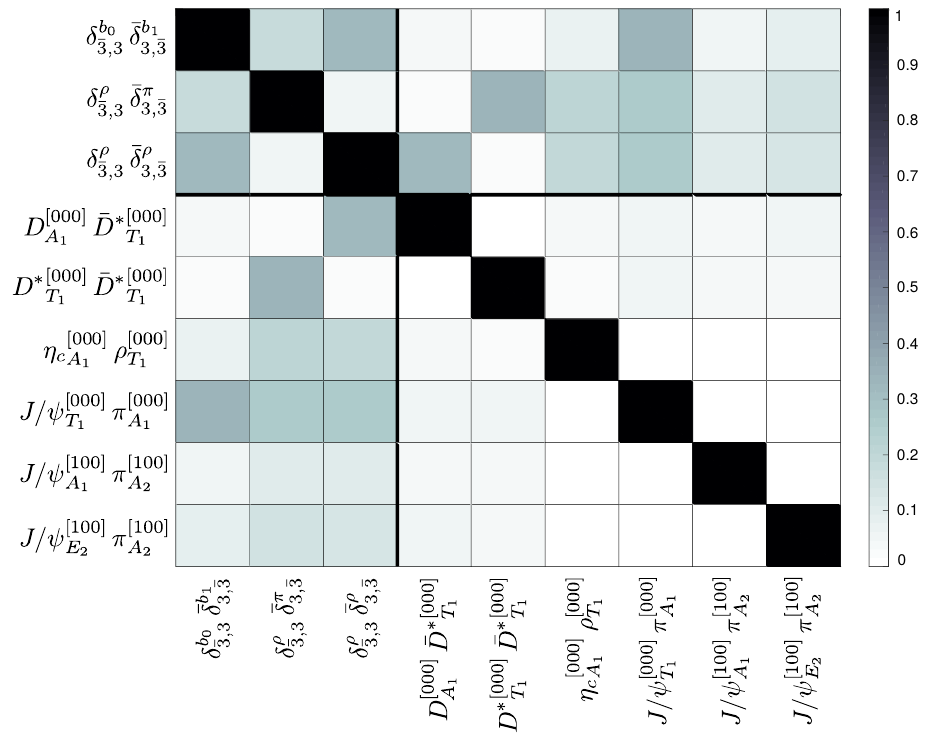
Figure 3 . Normalised magnitude of elements in the matrix of two-point correlation functions, j C ij j = p C ii C jj , on timeslice 3 in the (cid:3) PG = T ++ isospin-1 hidden-charm channel. The (cid:12)rst 1